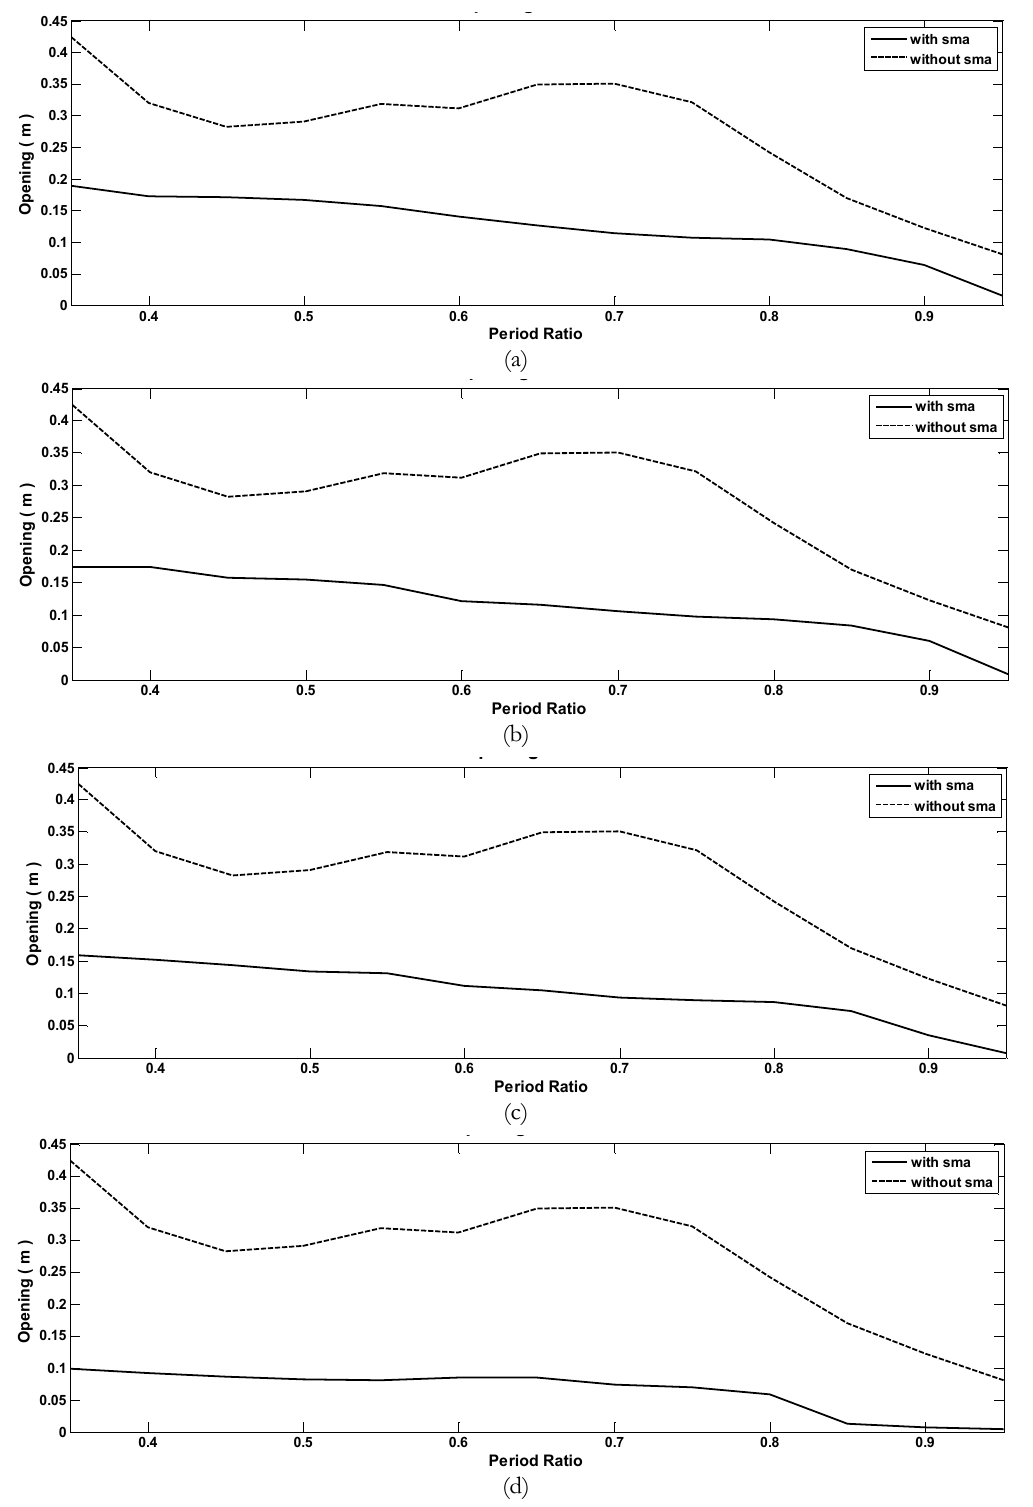
Figure 13: Comparison between MHD (opening) when using SMA and as–built bridge at various period ratios for variable mass ratio λ , (a) Mass ratio λ = 1.0; (b) Mass ratio λ = 0.75; (c) Mass ratio λ = 0.50; (d) Mass ratio λ =